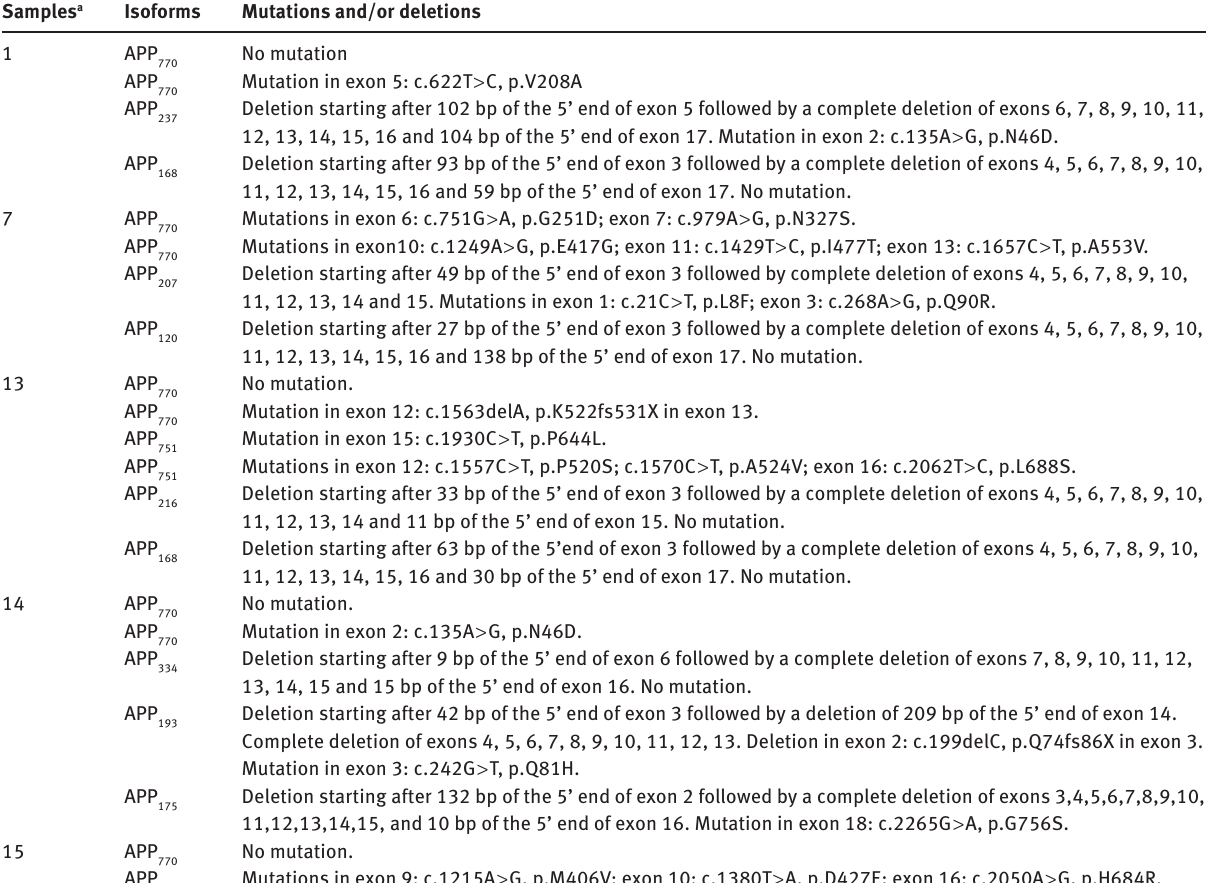
Table 1: Isoforms of APP and mutations/deletions. Samples